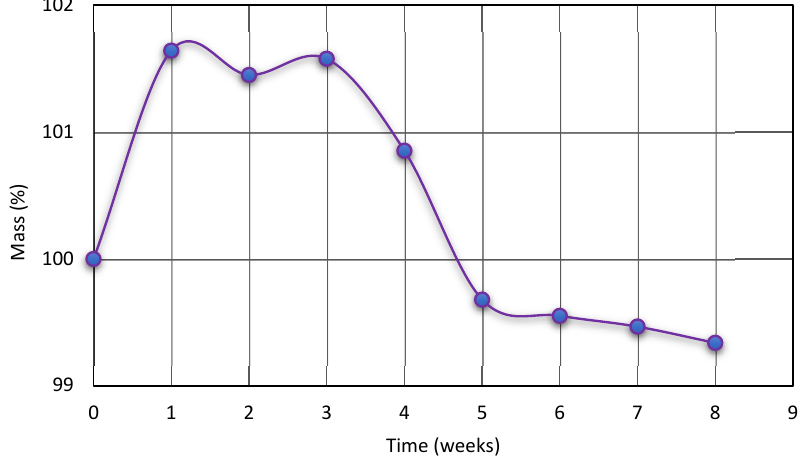
Figure 5. Diagram of sample mass change during Optylite ® liquid incubation.